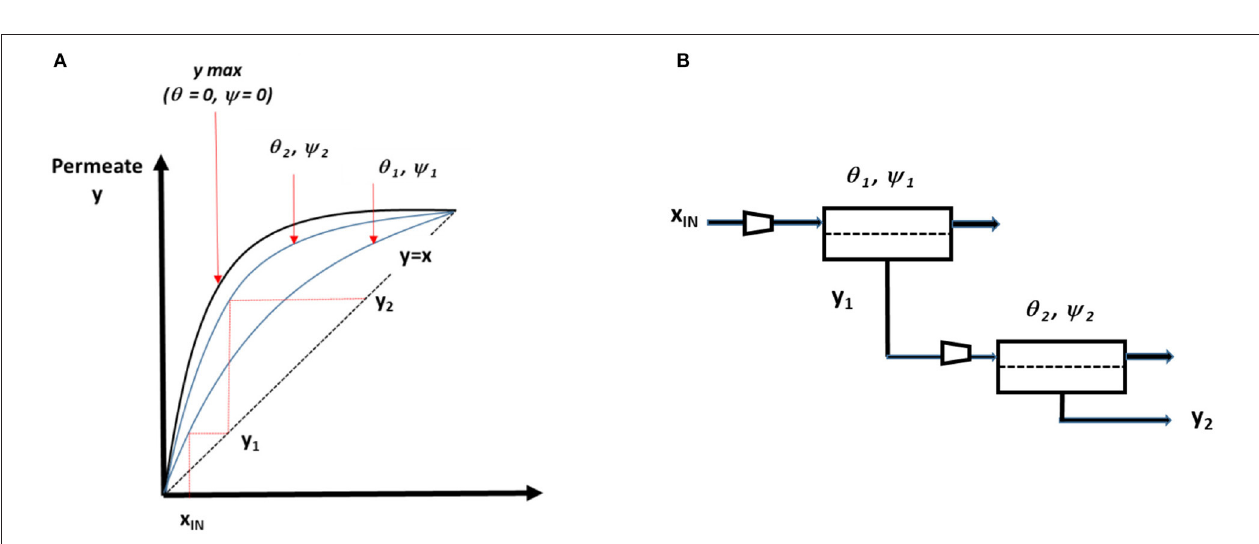
degree of freedom for each membrane stage, an increased CO